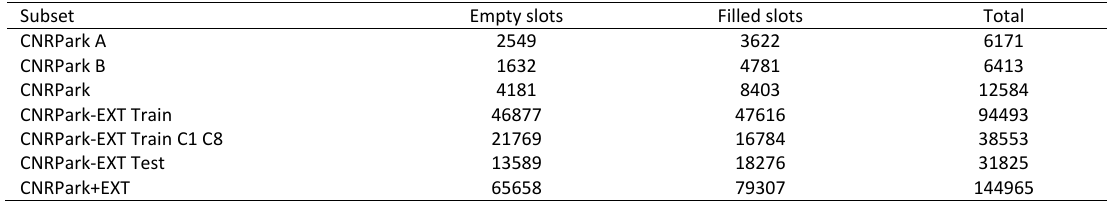
Table 2: Dataset details used as training and test data